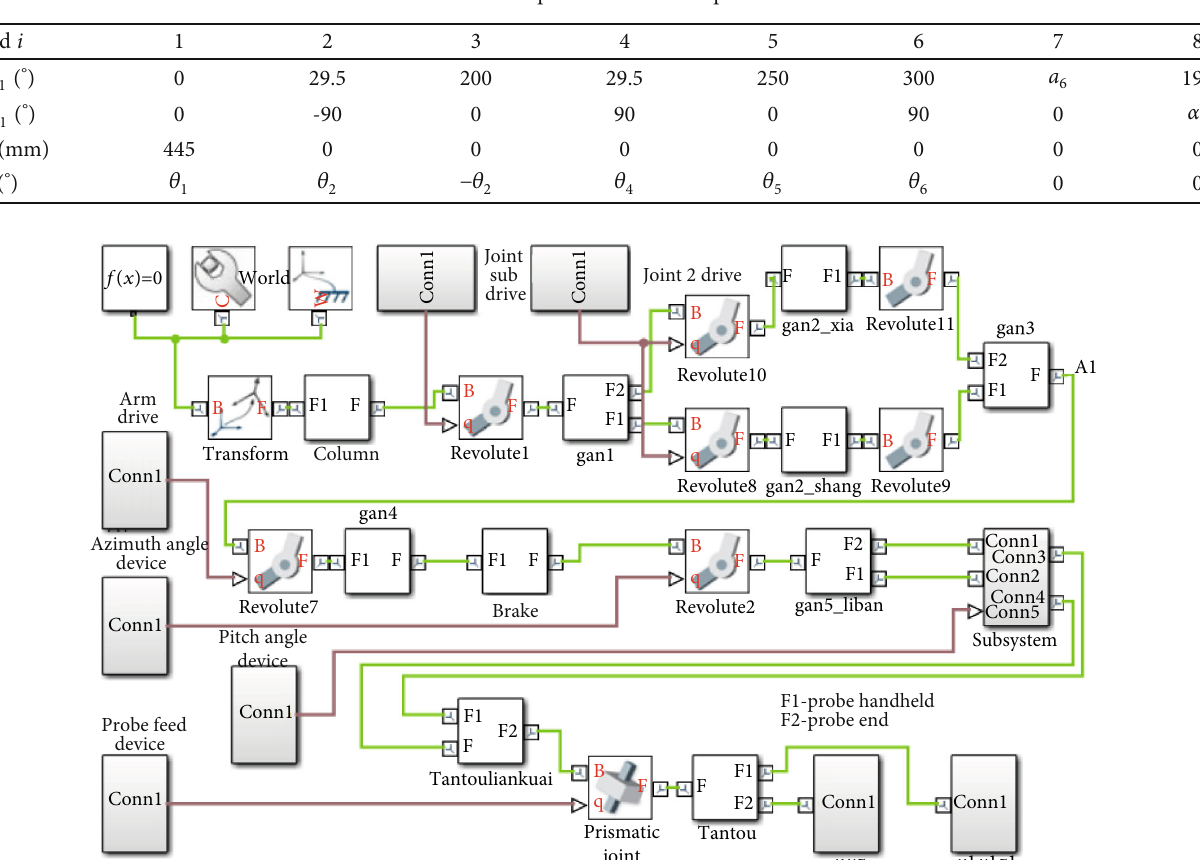
Figure 8: SimMechanics model of ultrasonic probe position adjustment mechanism. Table 2: Posture simulation parameters of ultrasonic probe